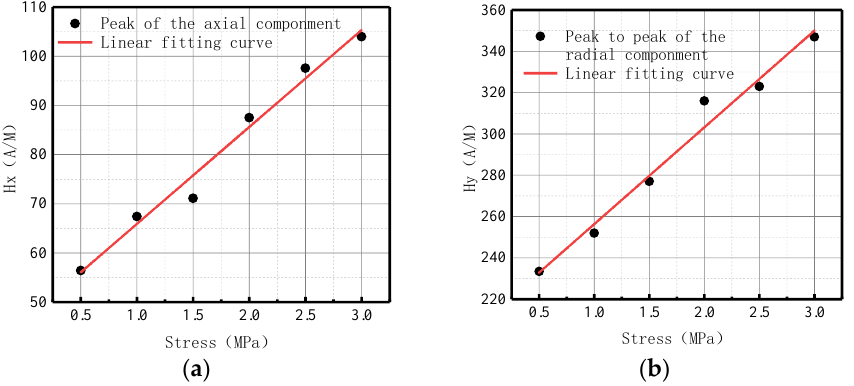
Figure 18. The peak values of weak magnetic signal at the crack of base metal changes with internal pressures. ( a ) Peak values of the axial component; ( b ) Peak-to-peak values of the radial component.